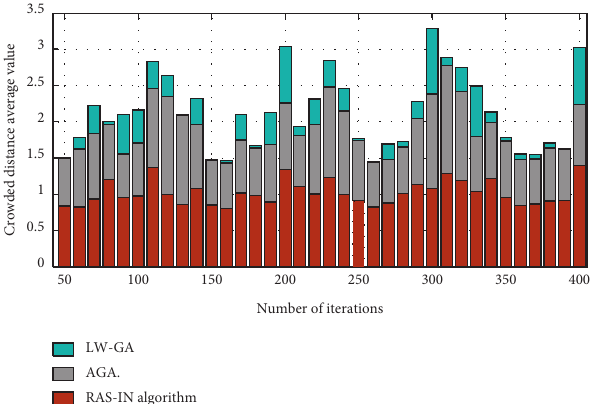
Figure 9: Comparison of the average crowded distance of the three